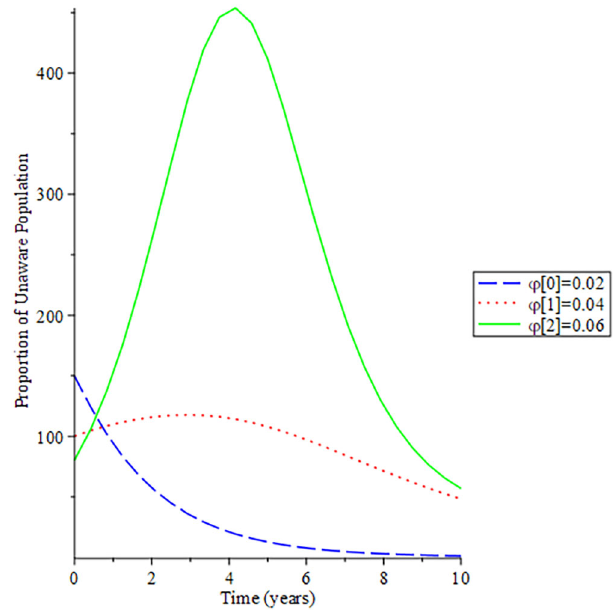
Figure 8. Behavioral dynamics of infected HIV unaware when varying vertical transmission φ with